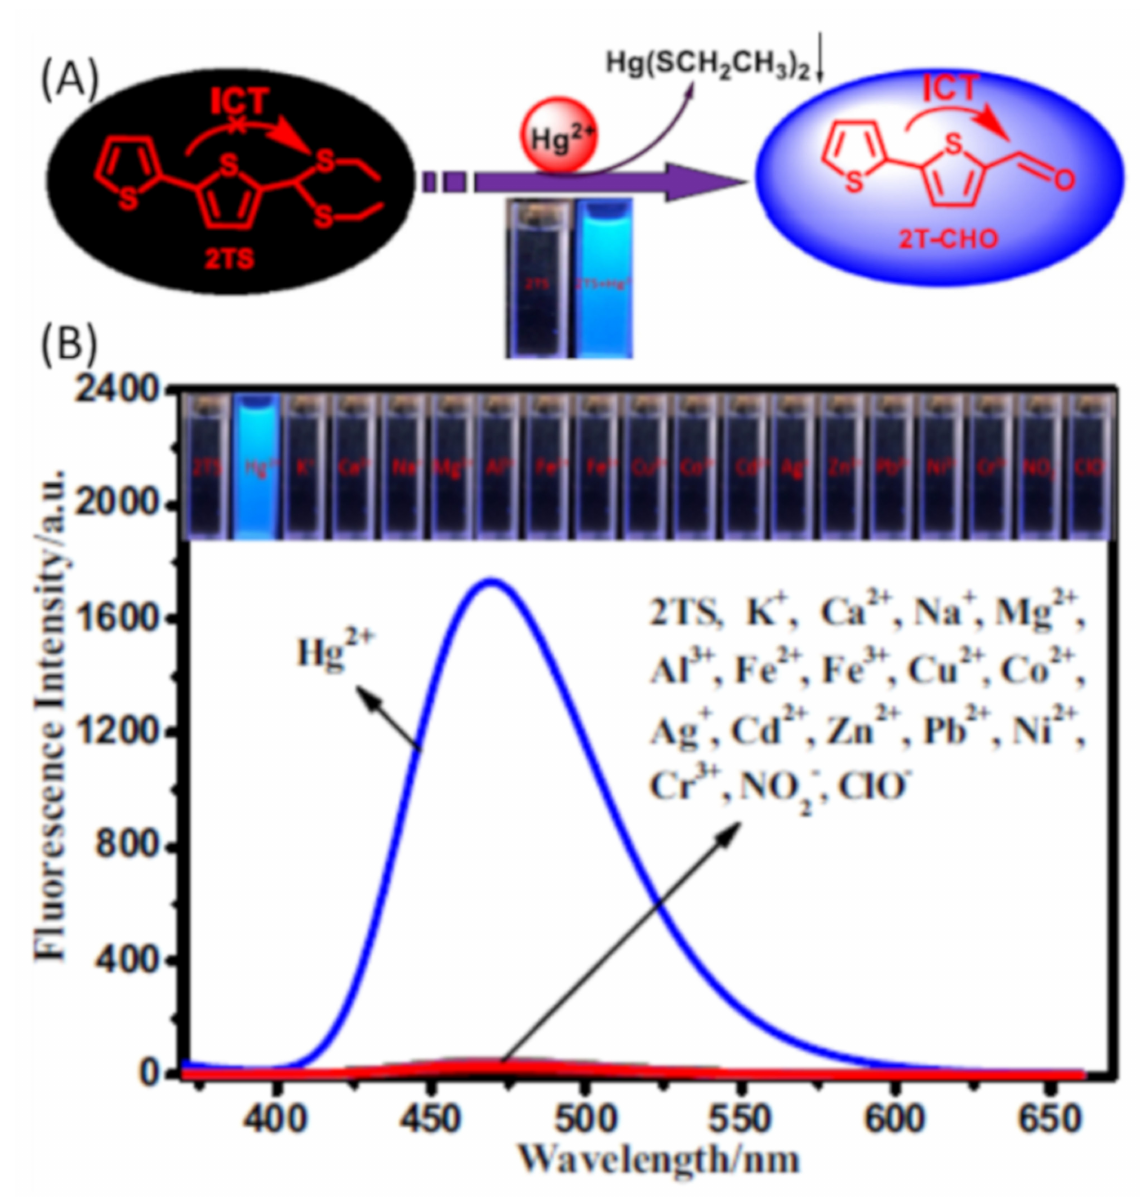
Figure 26. ( A ) Proposed sensing mechanism of 77 (2TS = 77 ) for Hg 2+ . ( B ) Fluorescence spectra of 77 (10 µ M) after addition of 20 µ M of various tested ions in 100% aqueous solution; Inset: fluorimetric responses of 77 (10 µ M) in 100% aqueous solution after the addition of various tested ions. Reproduced with permission from [105]. Copyright 2020